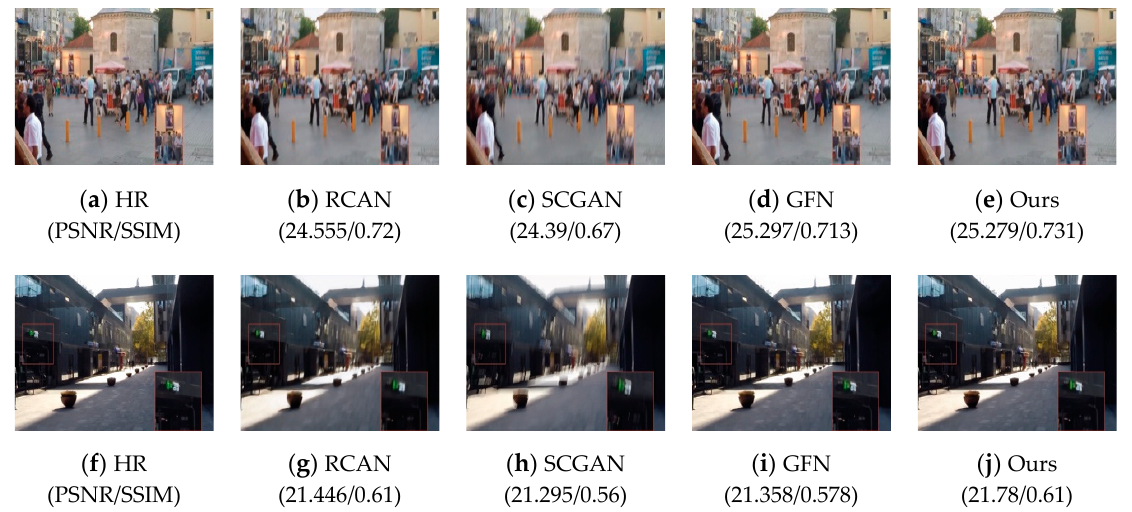
Figure 5. More visual comparison of our model with other methods on Lai et al. [34]. Table 2. The comparisons with SOTA methods of the quantitative performance on GOPRO da- taset [2]. Best results are marked in bold.